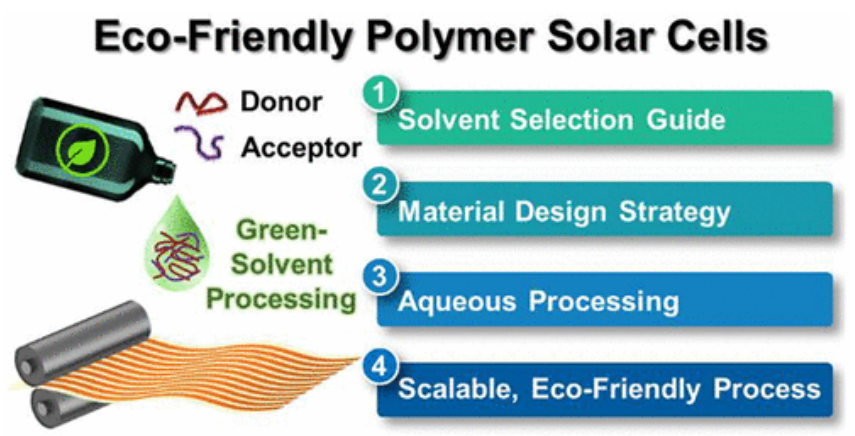
Figure 9. Design of eco-friendly polymer solar cells [85]. Reproduced with permission from ACS.